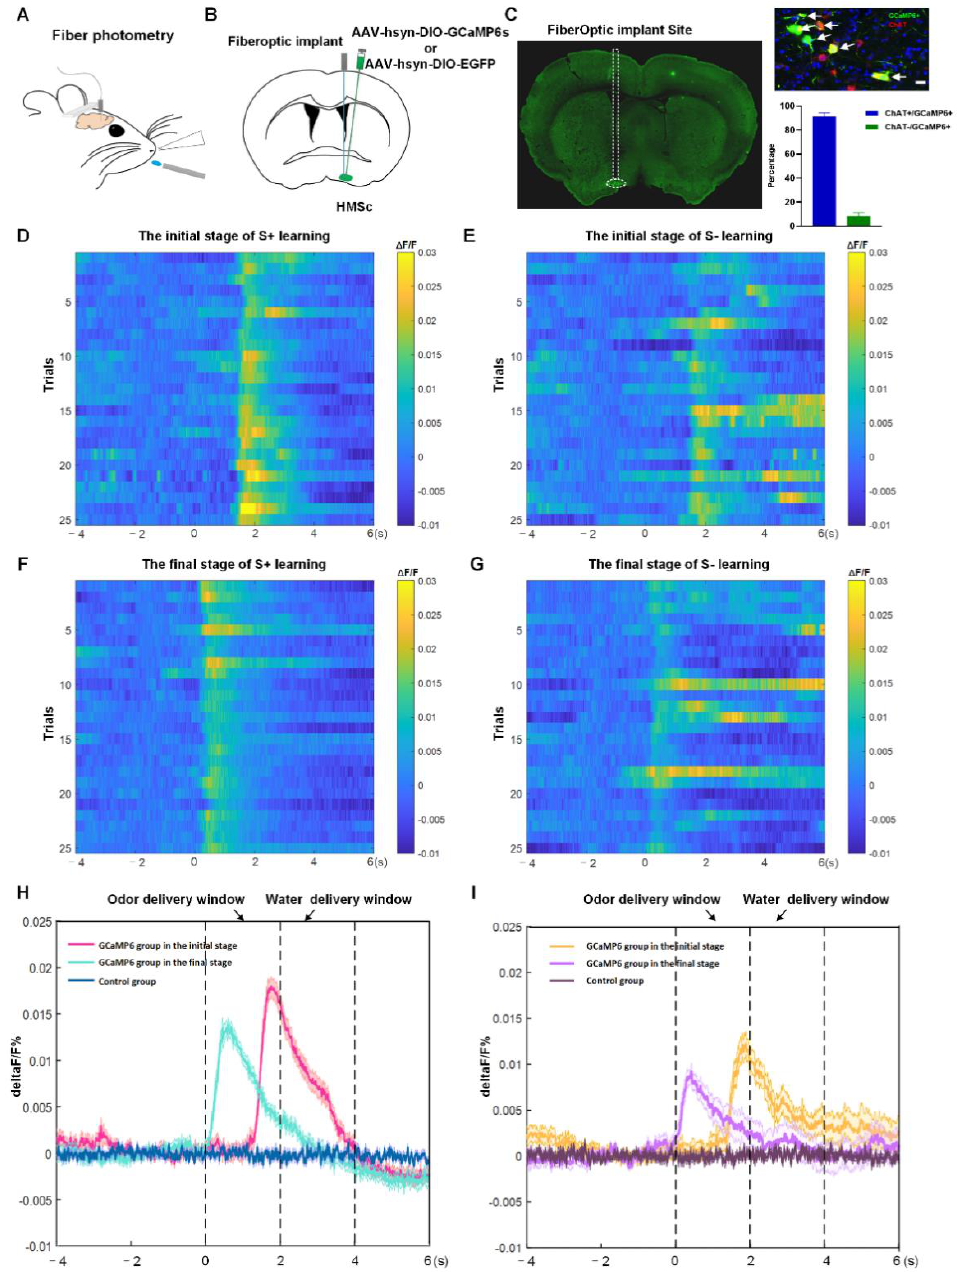
Figure 5. BFCNs in HMSc were activated in the go/no-go olfactory discrimination task. ( A ) Diagram of fiber photometry in head-fixed mice. ( B ) Coronal section schematic showing AAV injection site and fiber optic implanting in the HDB. ( C ) Site of optic fibers (left panel); representative immunofluorescent images of GCaMP6 (green), ChAT (red), and merge (yellow), scale bar: 20 µm (right panel, top); the percent of GCaMP6 expressed in cholinergic neurons in HMSc (right panel, bottom). ( D , E ) Heatmap showing responses of the cholinergic neuronal population for S+ and S− signals in the initial stage of go/no-go learning in the GCaMP6 group, respectively. ( F , G ) Heatmap showing responses of the cholinergic neuronal population for S+ and S− signals in GCaMP6 group in the final stage of go/no-go learning, respectively. ( H , I ) Responses of the cholinergic neuronal population for S+ and S − signals in control and GCaMP6 groups during go/no-go learning. n = 12, 5 mice in each group.